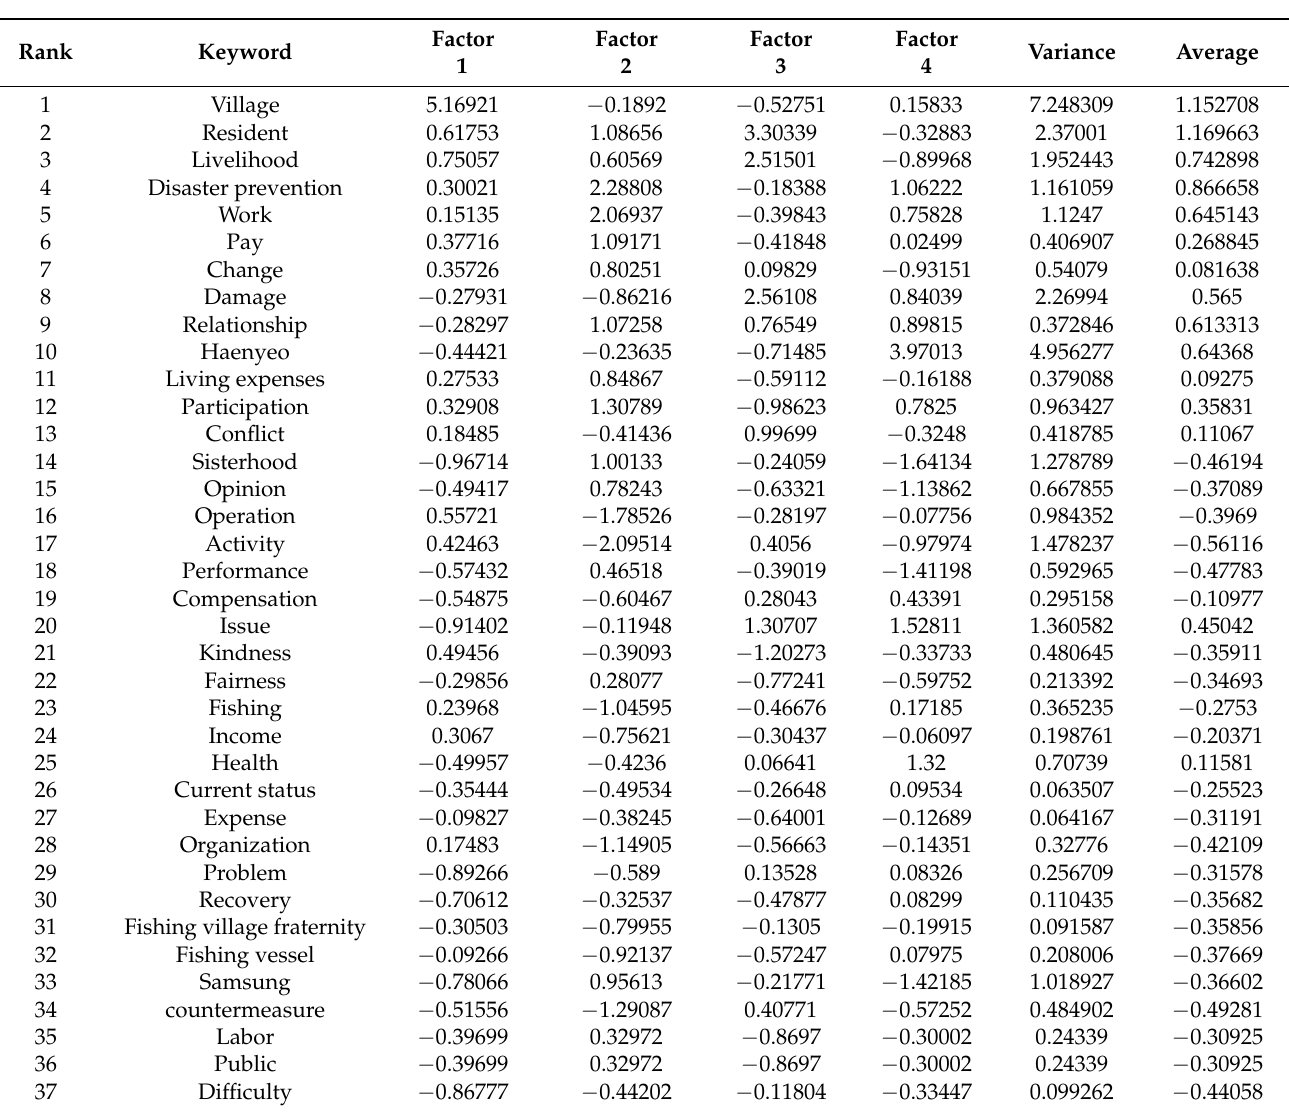
Table A1. Z values of the factors (raw data used for Table